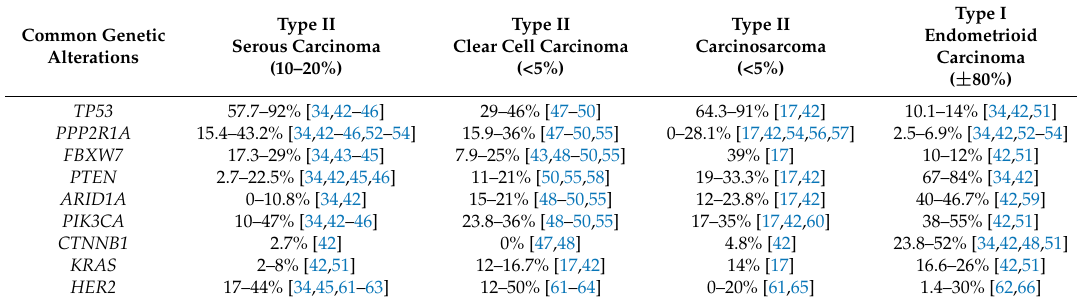
Table 1. Most common genetic alterations in type I and type II endometrial carcinomas (EC). Percentages in the header refer to all EC cases; percentages in the table refer to each EC